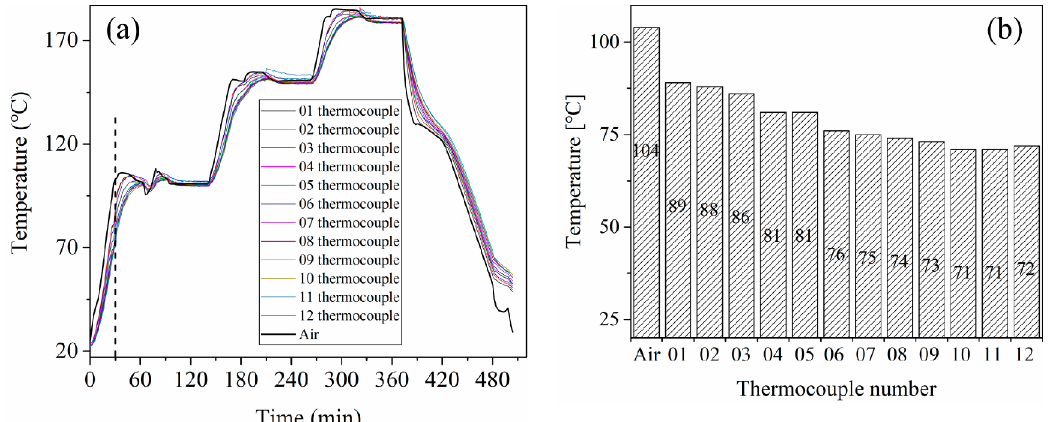
Figure 3. The temperature evolution of 12 points and the air temperature. ( a ) The entire process ( b ) at 30 min.